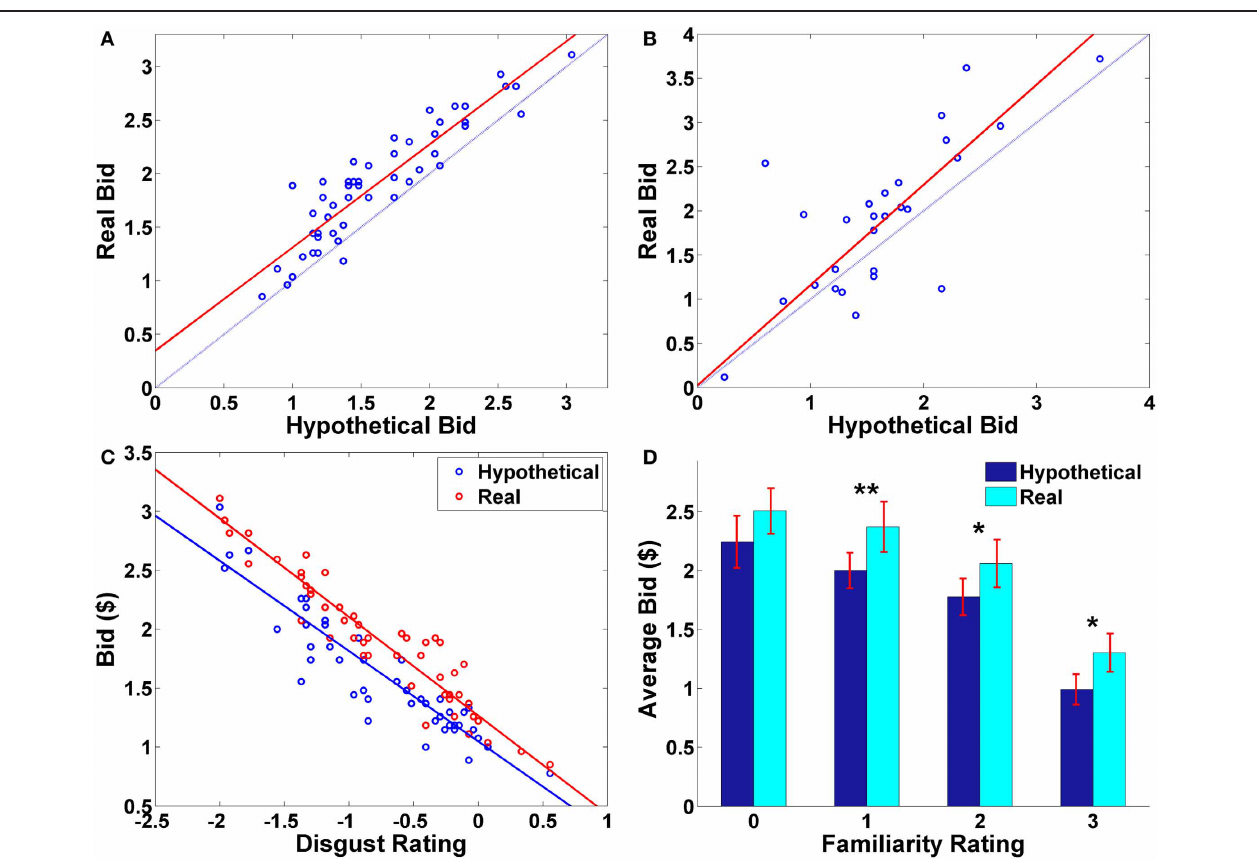
FIGURE 2 | Behavioral results. (A) Average bid by individual food item. Each point represents an individual food item. The red solid line indicates a robust regression line ( real bid = 0 . 96 · hypothetical bid + 0 . 35; p -values for coefficients: slope < 0.0001, intercept = 0 . 0026). (B) Average bid by individual subject. Each point represents an individual subject. The red solid line indicates a robust regression line ( real bid = 1 . 13 · hypothetical bid + 0 . 03; p -values for coefficients: slope < 0.0001, intercept = 0 . 9207). In (A,B) , the translucent blue line indicates a 45 ◦